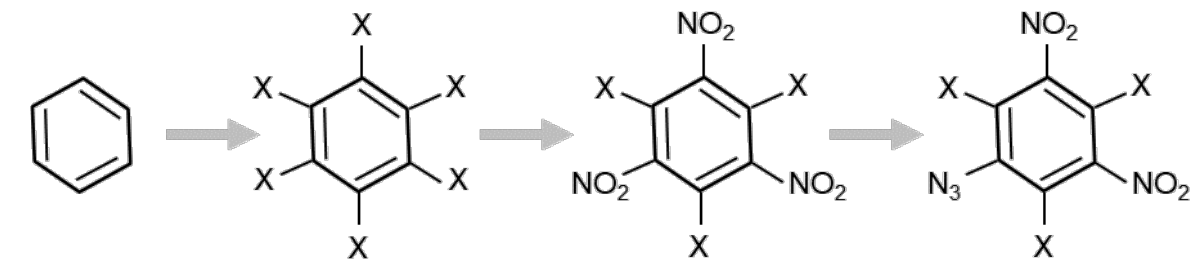
Figure 2. Scheme of the synthesis of a single-block halogenated nitro-azido biocidal energetic material, where X is a halogen atom. The figure has been adapted and modified from Ref. [69], where X = I.